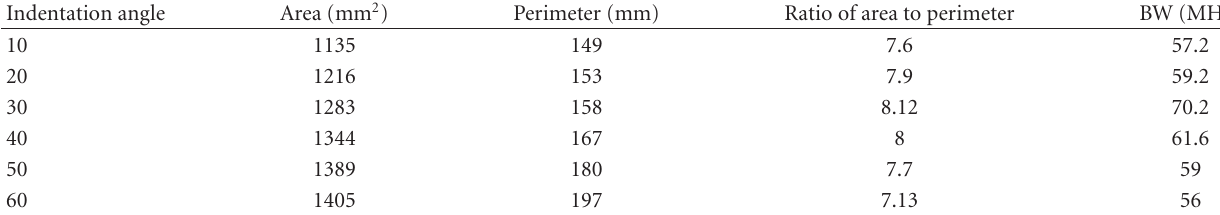
Table 4: Area and perimeters of 1st iterated fractal boundary antenna with di ff erent indentation angles ( a = 49 . 3 mm).